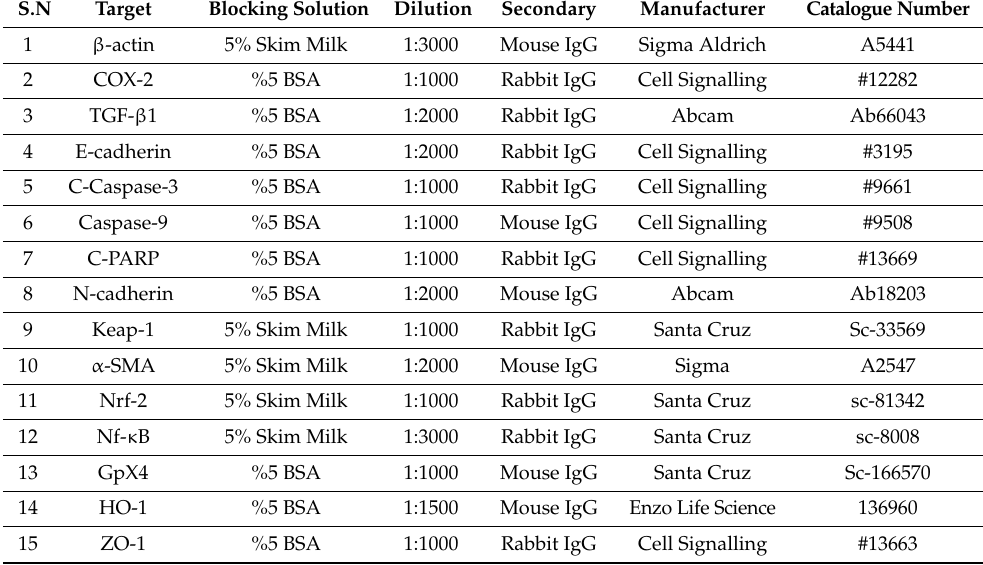
Table 1. List of specific antibodies and secondary antibodies used for immunoblotting.